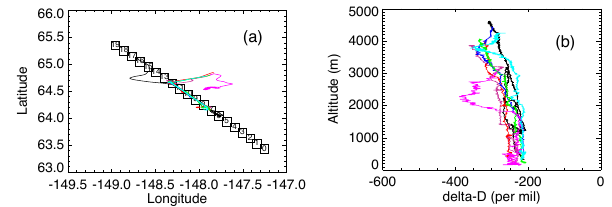
Figure 1. (a) Aircraft paths of seven flights over the Alaskan inte- rior boreal forest (color-coded by flight date). Also plotted are the geolocations of the TES transect special observation (squares la- beled by scan numbers 0 through 19). (b) Vertical profiles of water vapor δ D from the seven aircraft flights. The 12 July 2013 flight (magenta line) had the largest excursion in δ D at 2000m altitude. This was a layer of isotopically depleted air observed both on air- craft ascent and descent in the free troposphere above the top of a well-defined boundary